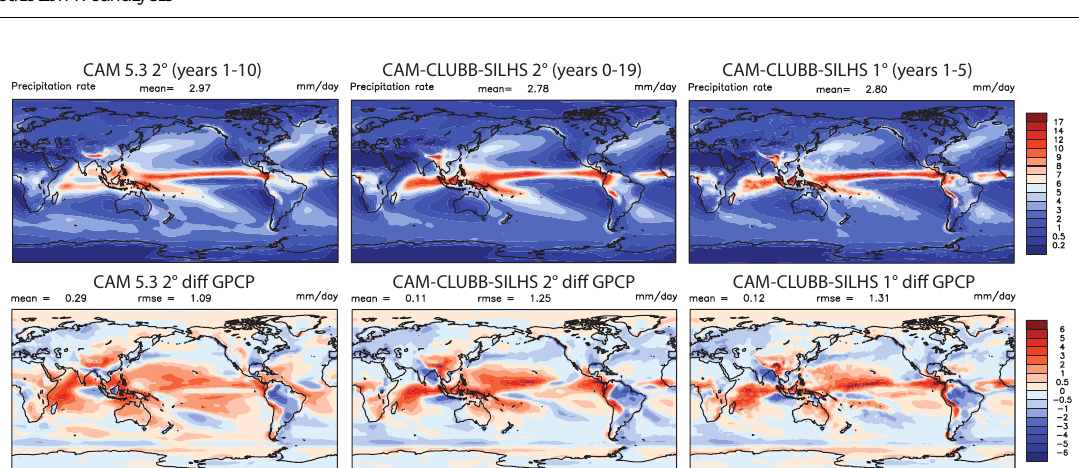
Figure 2. Total surface precipitation rate for CAM 5.3 (left), CAM-CLUBB–SILHS 2 ◦ (center), and CAM-CLUBB–SILHS 1 ◦ (right). The difference from GPCP observations of precipitation rate is shown in the second row. CAM-CLUBB–SILHS has more intense precipitation, but less of a double ITCZ than CAM